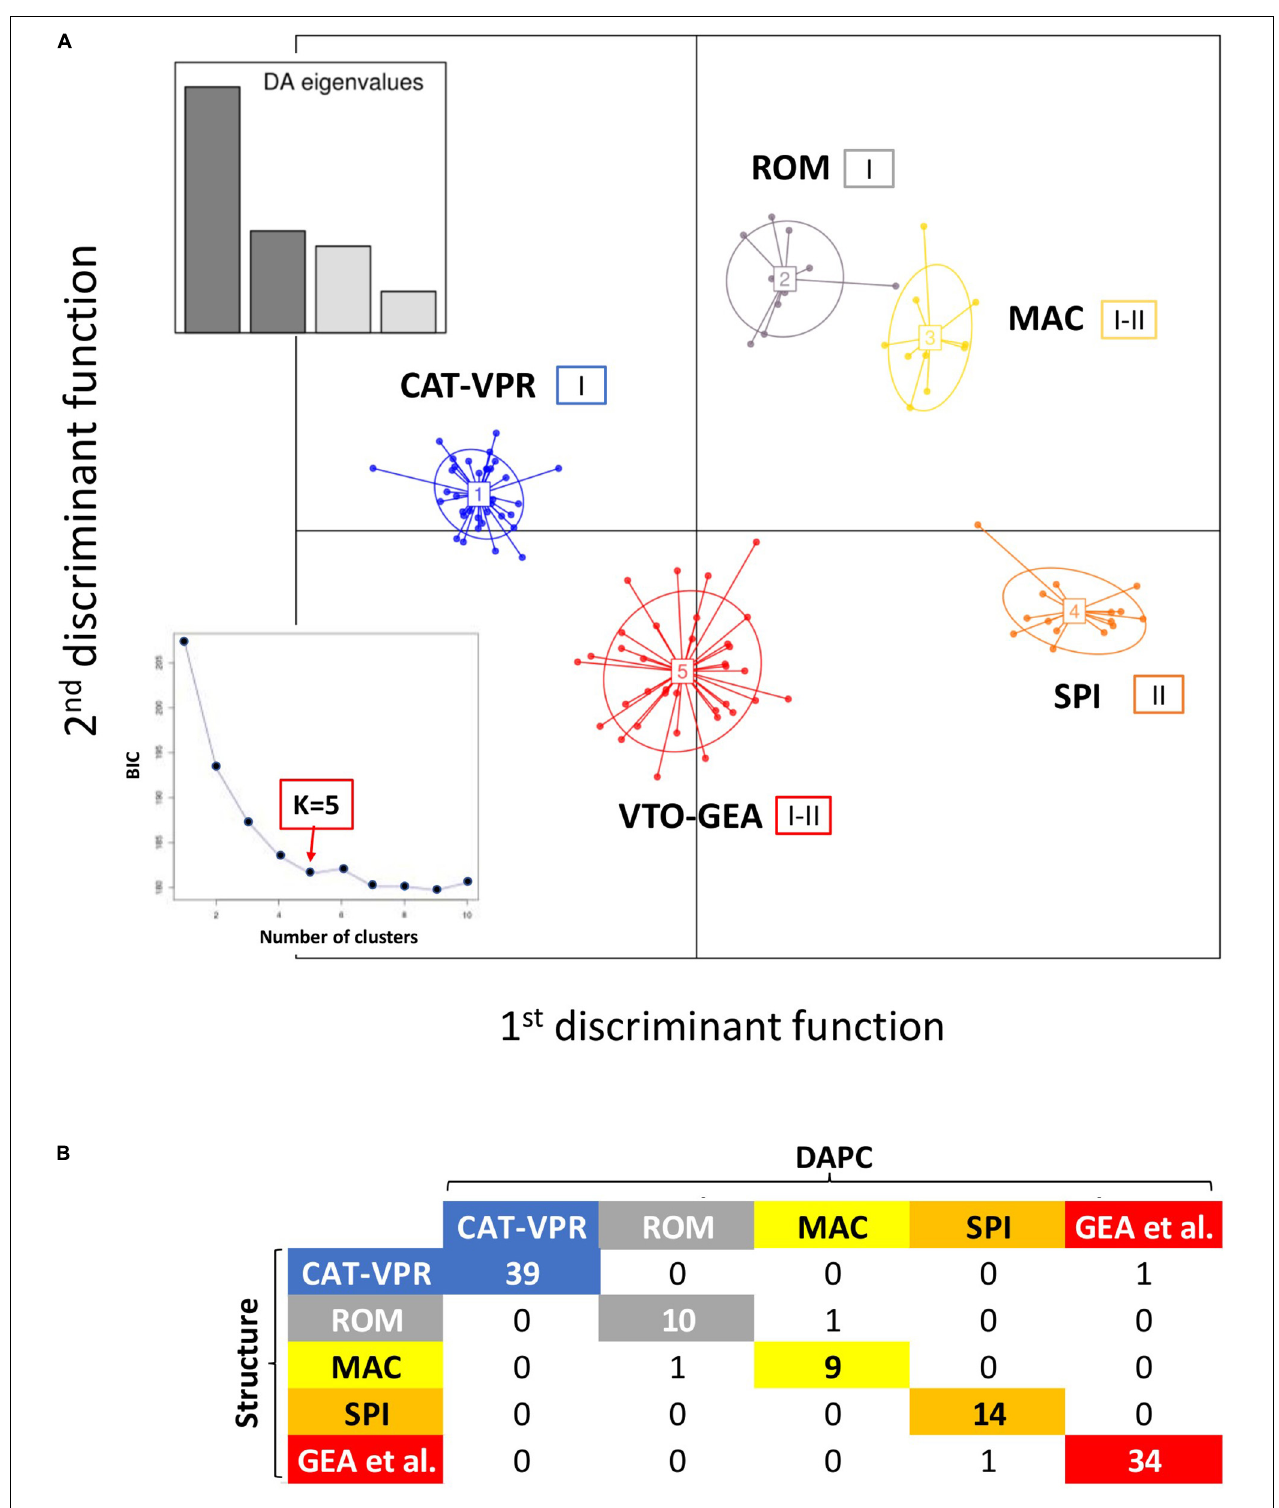
FIGURE 2 | Discriminant analysis of the principal components (DAPC). (A) Five groups of cultivated globe artichoke varieties as depicted by the first two discriminant functions. Insets, left: eigenvalues for the first four discriminant functions. The small square embedded in the lower left part of the figure represents the BIC values as a function of the numbers of assumed genetic groups. Roman numbers (I and II) indicate the chloroplast alleles observed within each nuclear SSR group. (B) Correspondence between the Structure and DAPC classifications.